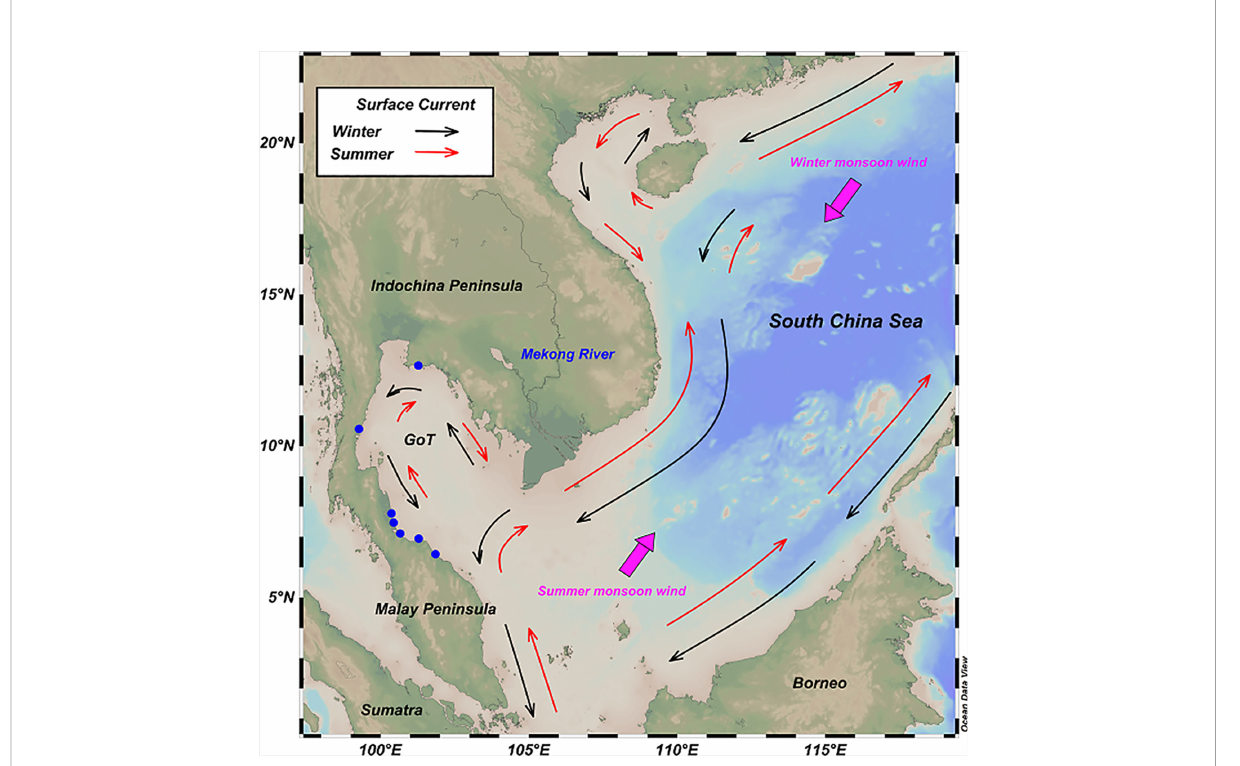
FIGURE 3 Gulf of Thailand (GoT) surface current (modi fi ed from Liu et al., 2016). Surface currents in winter (black) and summer (red) surface currents. The blue solid circle represents a sampling station from the bottom – up, namely NTNW, PNTC, SKBI, SKMH, SKPT, CPTW, and